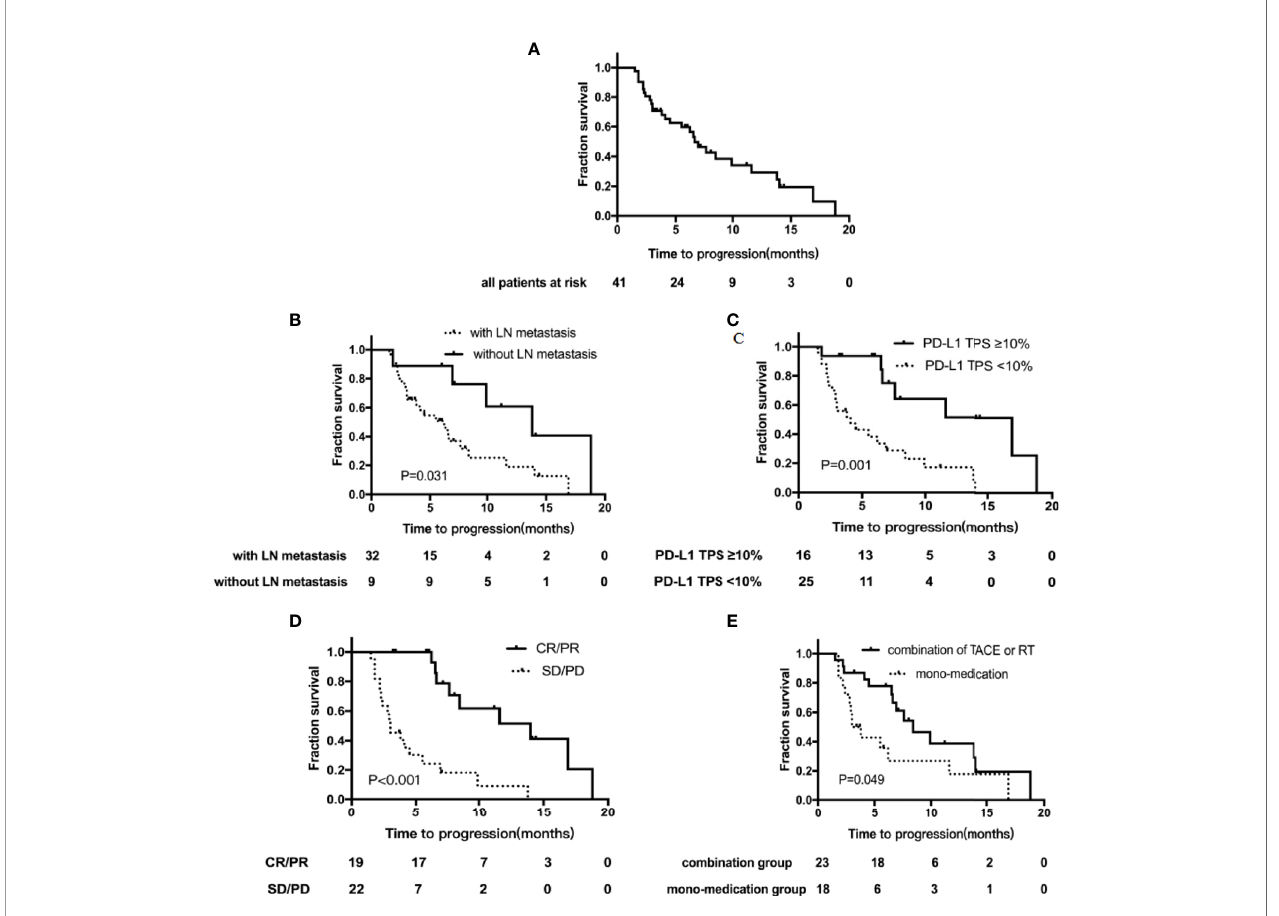
FIGURE 2 | Kaplan – Meier curves showing the time to progression (TTP). (A) TTP for the whole group; (B) TTP by LN metastasis subgroups; (C) TTP by PD-L1 TPS expression subgroups; (D) TTP by tumor remission subgroups; (E) TTP by different treatment subgroups. TACE, transarterial chemoembolization; RT, radiation therapy; TPS, tumor proportion score; LN, lymph